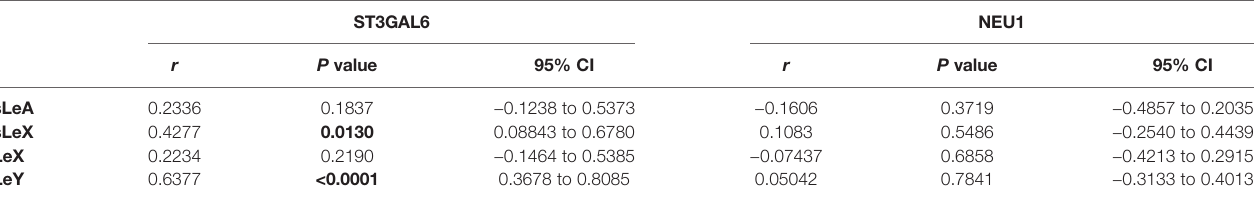
TABLE 3 | Spearman ’ s rank correlation coef fi cients of the expression of ST3GAL6 and sLeA, sLeX, LeX, and LeY. ST3GAL6 NEU1 r P value 95% CI P value 95%